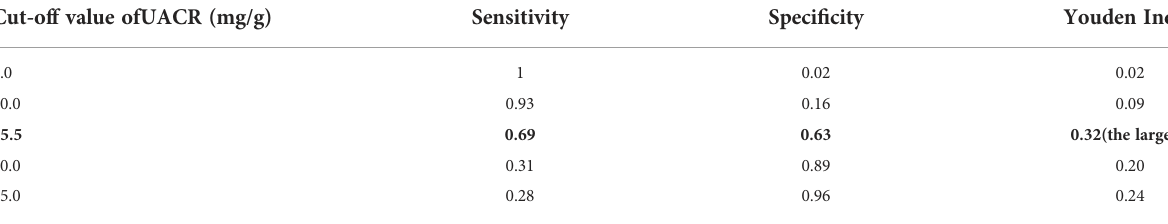
TABLE 8 Sensitivity, speci fi city and youden index of the UACR at different cut-off values. Cut-off value ofUACR